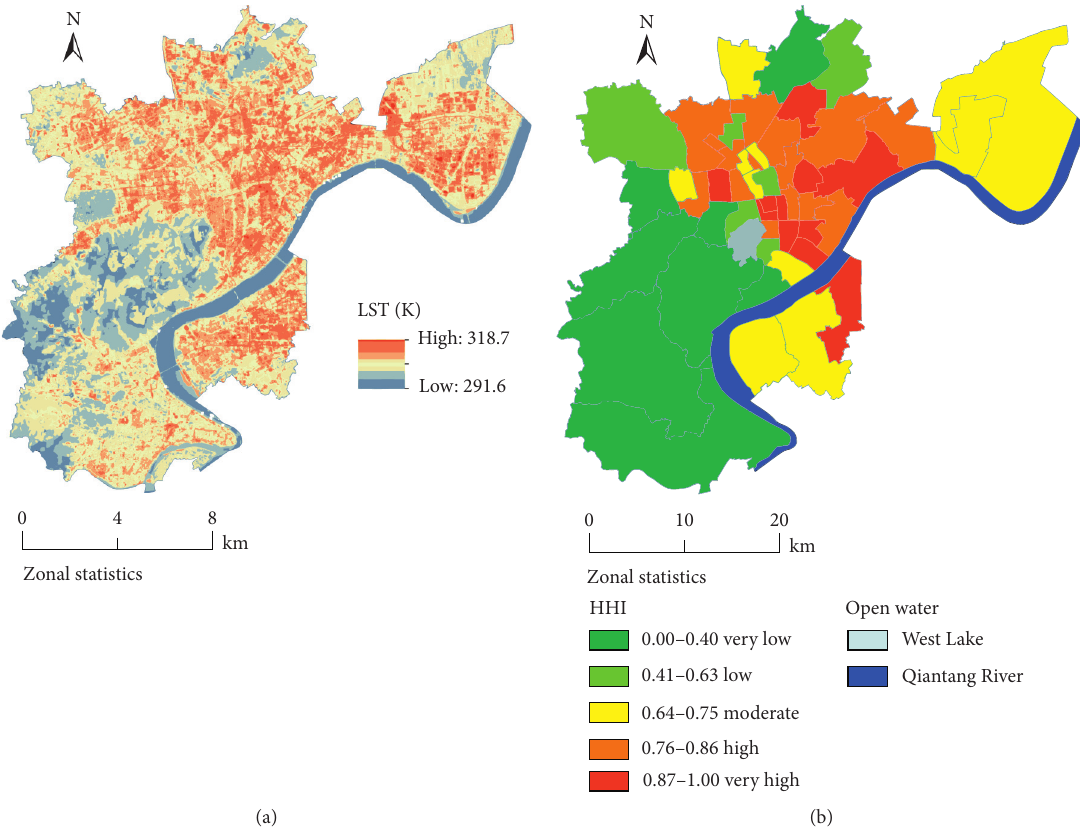
Figure 2: (a) The mean LST (June to August) at the pixel level; (b) the mean HHI at the subdistrict